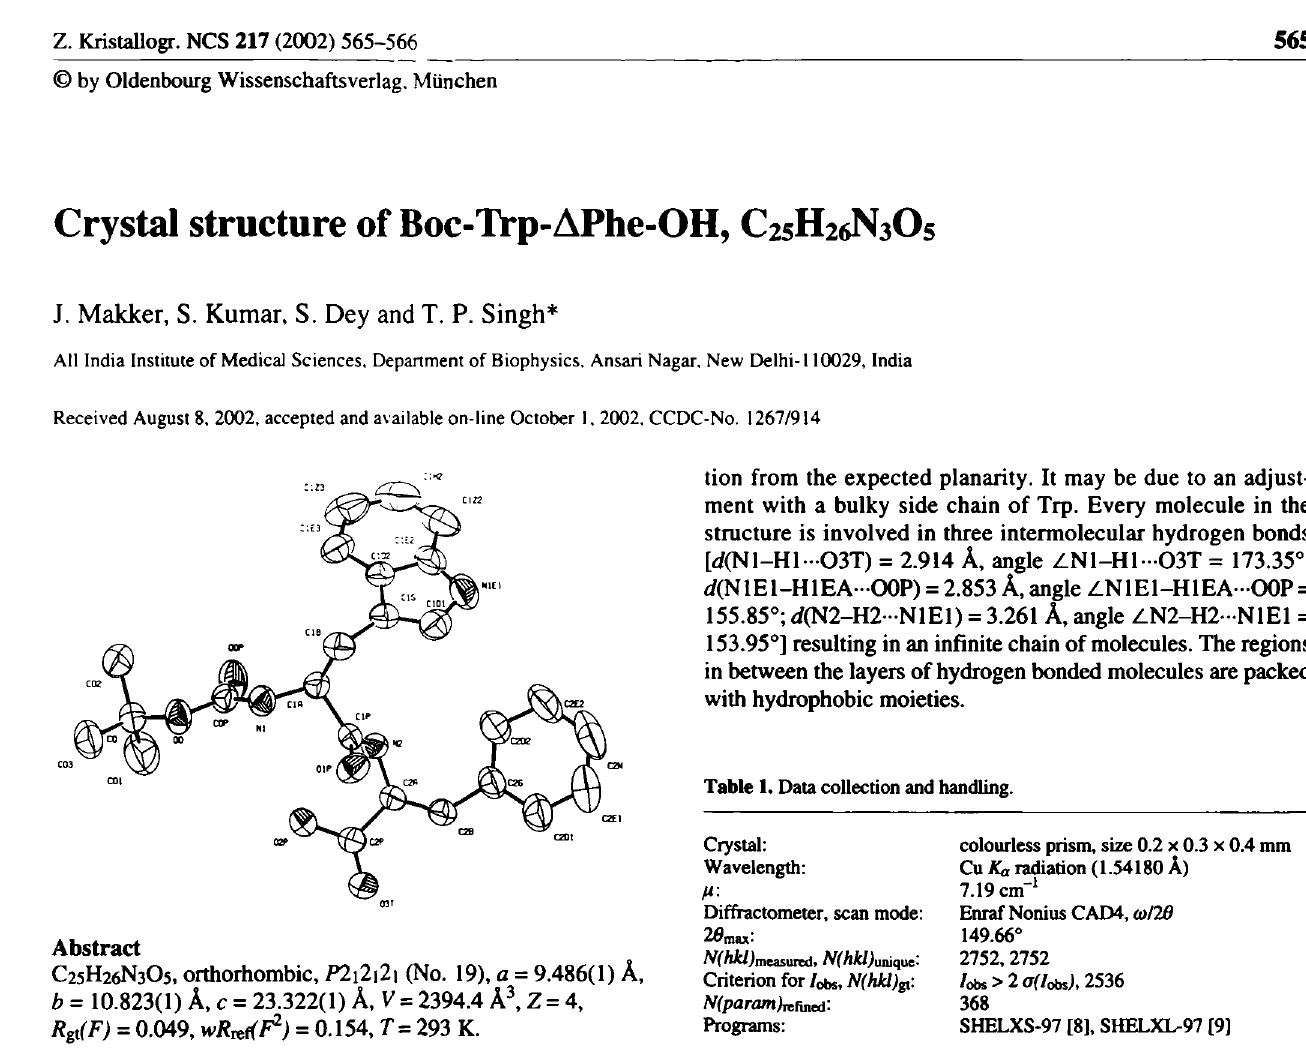
Table 2. Atomic coordinates and displacement parameters (in Â 2